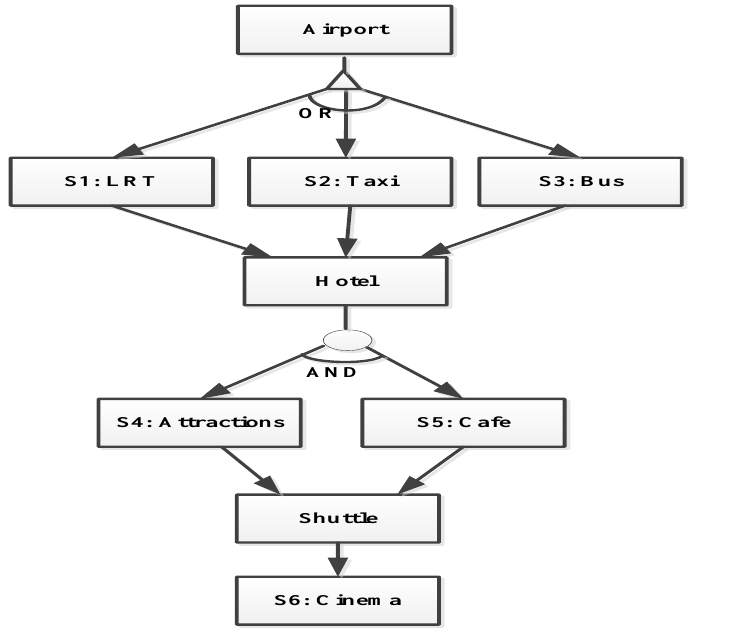
Figure 4. Trust-based service composition (tourist plan).